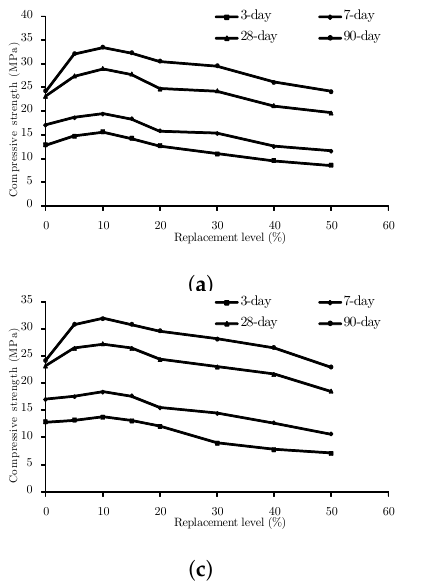
Figure 7. Effect of ( a ) MK-FA, ( b ) MK-ZE, ( c ) FA-ZE on the compressive strength of concrete at different